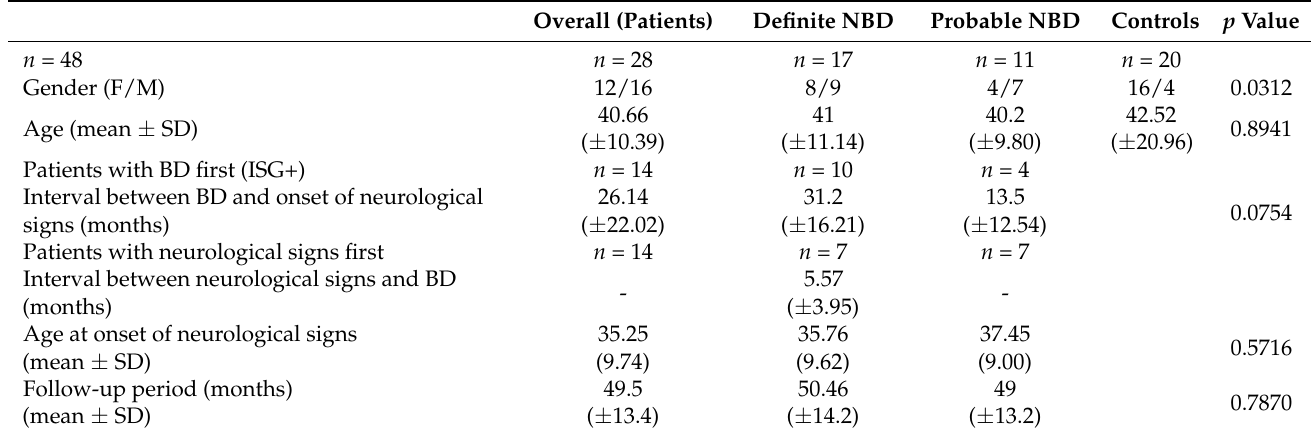
Table 1. Demographic and clinical characteristics of subjects included in the study.